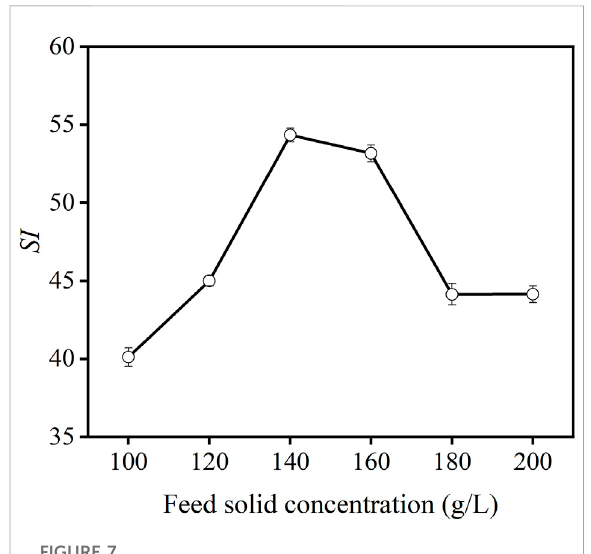
FIGURE 7 Effect of feed solid concentration on SI of carbon anode slag fl otation (grinding time 40 min, colletor dosage 1,000 g/t, frother dosage 500 g/t).